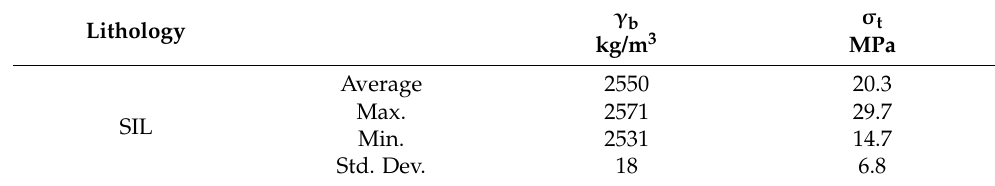
Table 6. Statistical values of the tested physical and peak strength properties of five disc samples from the silicified limestone (SIL). γ b : bulk density; σ t : indirect tensile strength measured via Brazilian test. γ σ t b Lithology kg/m 3 Average SIL